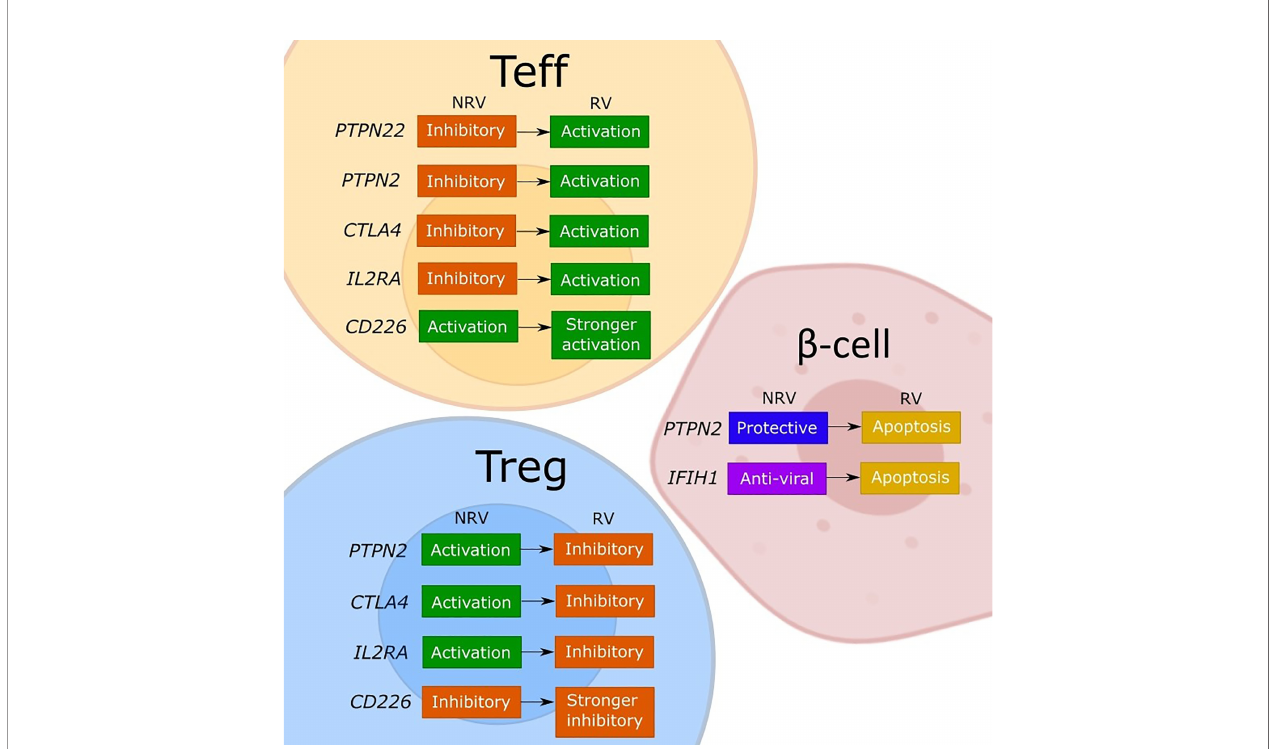
FIGURE 1 | Model of the discussed effects of T1D risk variants on cellular functions. The fi gure depicts our interpretation of the consequences for effector T cell (Teff), regulatory T cell (Tregs), and b -cells of the described or assumed change in the gene function caused by a T1D risk variant (RV) as compared to the non-risk variant (NRV) SNP as discussed in the manuscript. While the LYP protein normally controls the effector T cells by a downstream signaling inhibition, the risk variant (rs2476601) induces a change in PTPN22 that promotes Teff responses. The functional effects of PTPN22 remain unclear. The PTPN2 protein plays an anti- apoptotic role in b -cells and controls T cells via IL-2, which may favor Tregs due to a strong sensitivity to IL-2. Indirectly, a good activity of Tregs keeps the effector T cells under control. The PTPN2 risk variant (rs1893217) causes a decrease in PTPN2 expression and contributes to the sensitivity of b -cells to immune- or virus- mediated apoptosis. The risk variant also reduces IL-2 receptor signaling, which decreases FOXP3+ Tregs in T1D patients, and thus dysregulating Treg function. The PTPN2 de fi ciency (mimicking the rs1893217 variant) results in increased Teff proliferation. The MDA5 (encoded by IFIH1 ) normally functions to activate stress- and anti-viral response, and by increasing the activity of MDA5, the risk variant (rs1990760) increases the basal IFN-I production leading to b -cell apoptosis. CTLA-4 functions normally to promote Treg function and inhibit Teff activation. The risk variant for CTLA4 (rs231775) results in decreased expression of CTLA-4 on T cells, releasing the control of a Teff cell activation and reducing the suppressive Treg potency. The IL2RA risk variants impair the expression of CD25 and thus the IL-2 response and with the associated lower FOXP3 expression impacts primarily Tregs and their suppressive function. The resulting reduced Treg potency will indirectly release the control on Teff promoting the activation. The CD226 is an activating T cell molecule that promotes the in fl ammatory activity of Teff and reduces the suppression of Tregs. The CD226 risk variant (rs763361) results in an isoform of CD226 with increased activity, which further increases Teff and CD226+ Tregs, thereby further reducing the overall suppressive capacity of